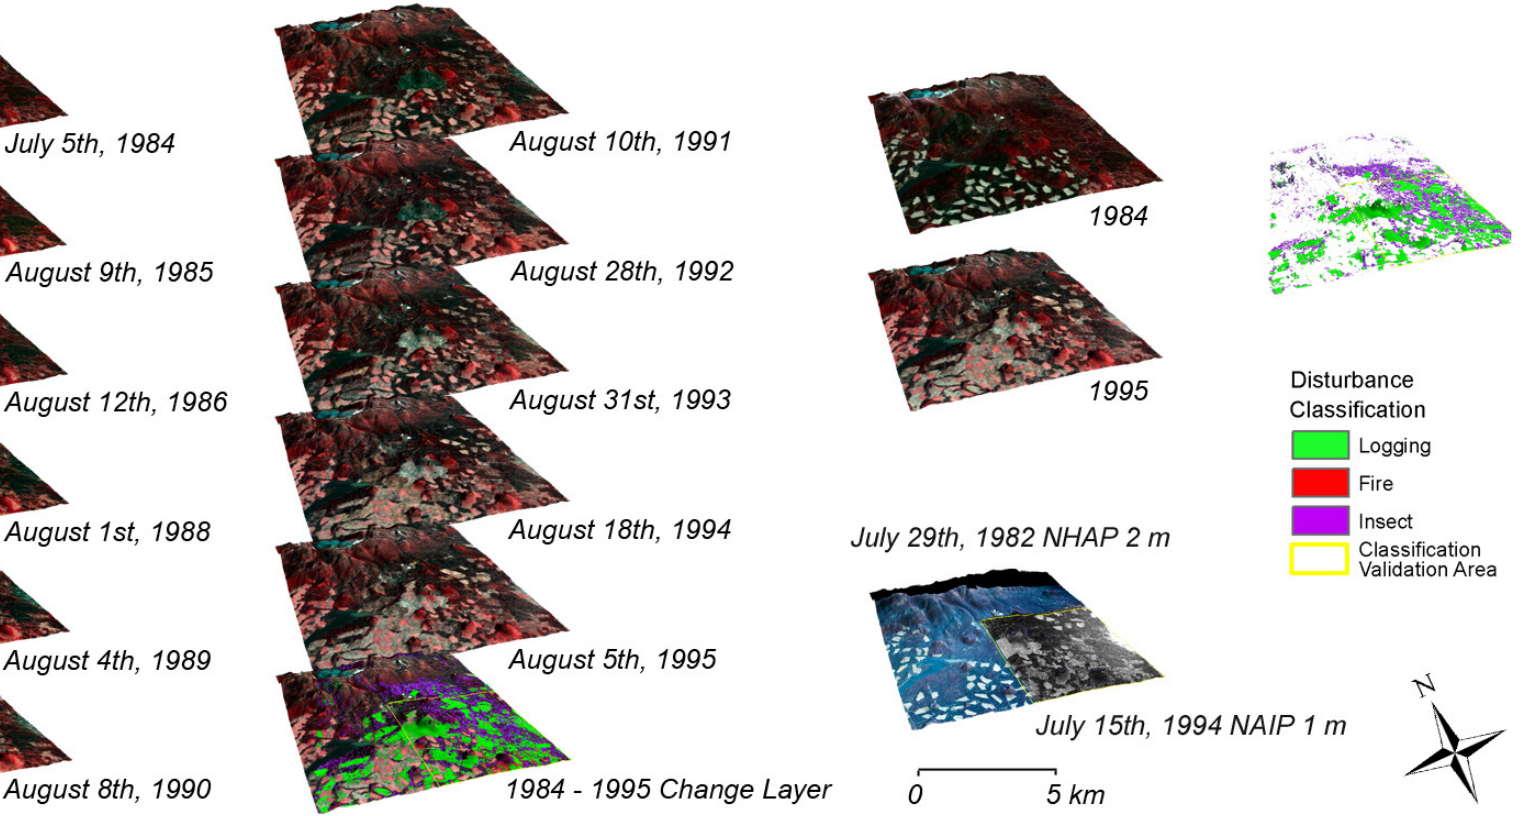
Figure 5. Example of Landsat classification for a subset region of Path 44 Row 30, which covers one AVHRR pixel, displayed in 3D with the shuttle radar topography mission (SRTM) digital elevation model. The yellow inset box corresponds to the region of air photo date overlap between NHAP and NAIP used for accuracy assessment (Figure